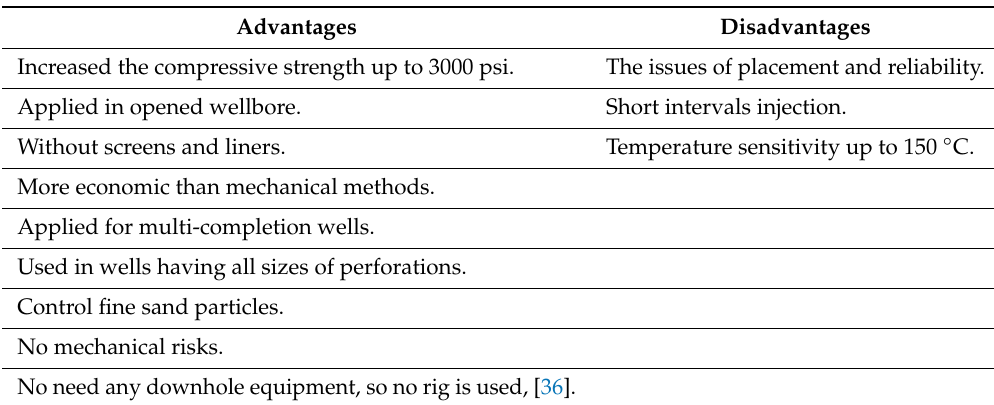
Table 12. Advantages and disadvantages of oxidation and hydrocarbon methods.